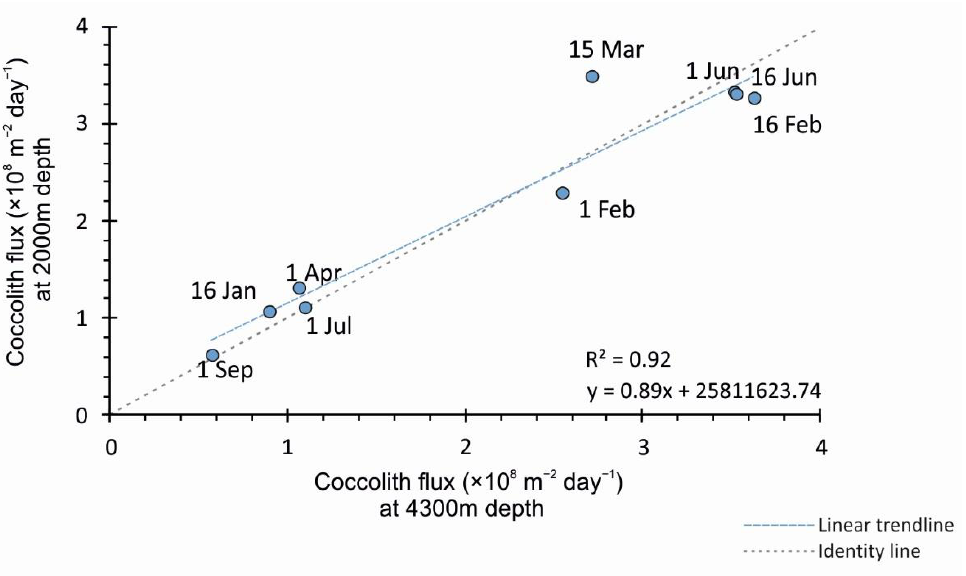
Figure 5. Correlation of the total coccolith fluxes recorded at 2000 m by Skampa et al. [13] with their fluxes at 4300 m during 2015 recorded in the present study.